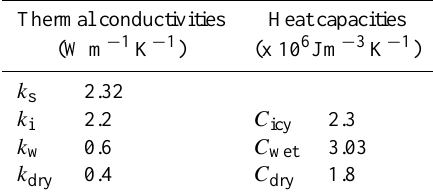
Table 2. Values of the thermal parameters used in